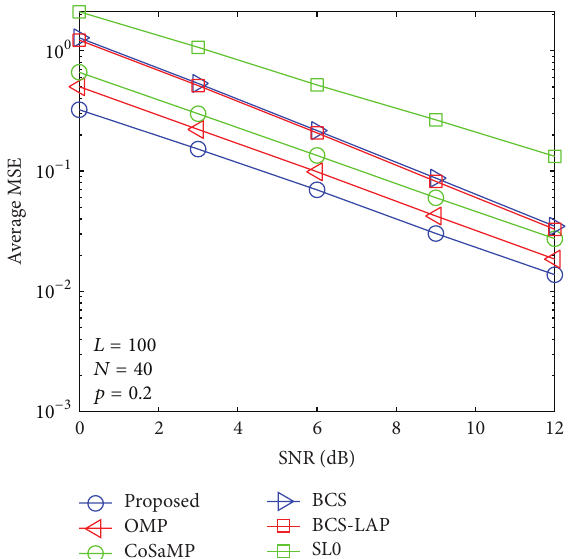
Figure 10: Average BER performance versus SNR when 𝑝 1 = 0.1 and 𝑁 = 30